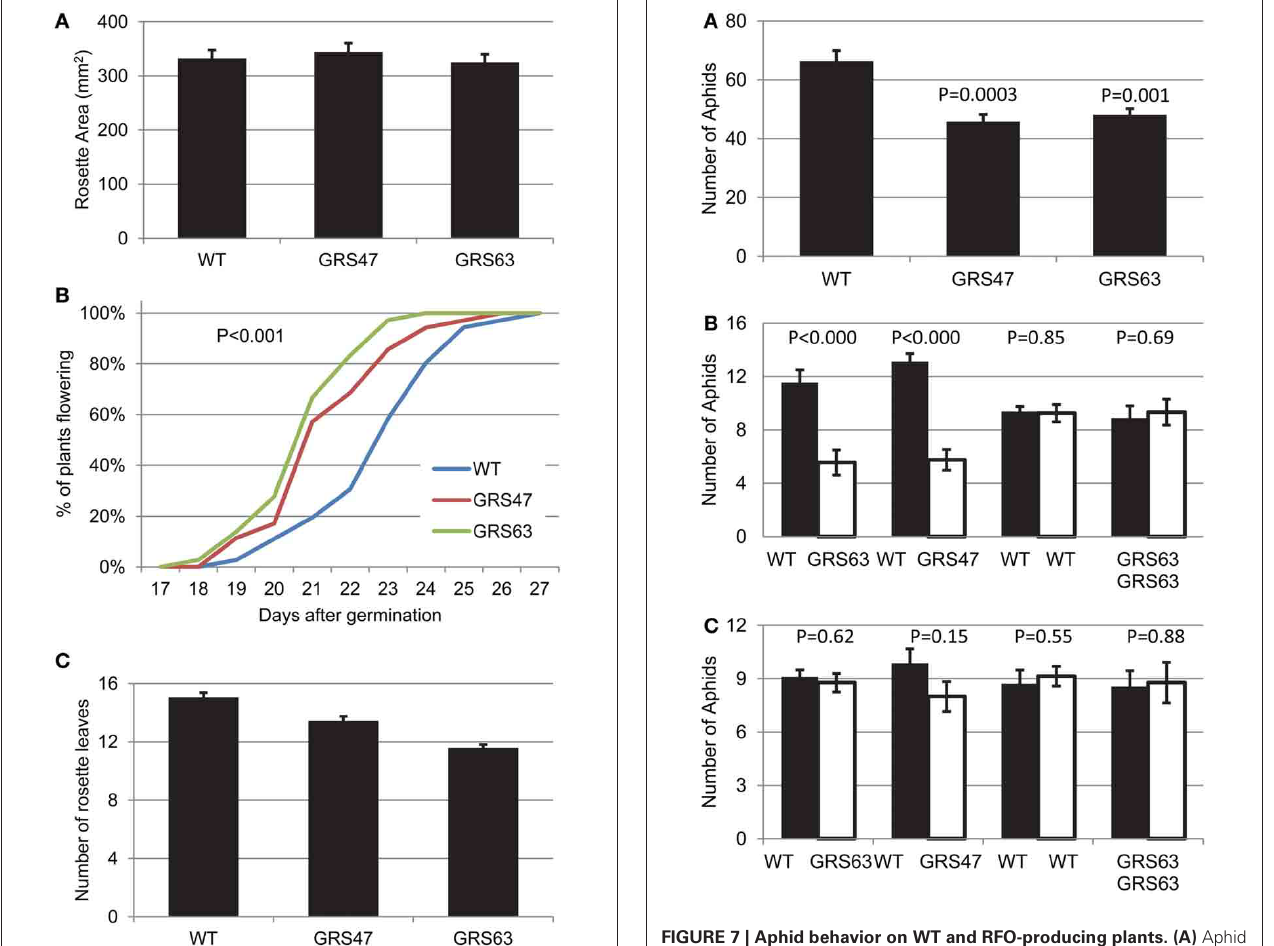
FIGURE 7 | Aphid behavior on WT and RFO-producing plants. (A) Aphid populations on each plant after 48h in a “no-choice” experiment (starting population = 20 adults). Average and SE, n = 12. (B) Adult aphids settled on each plant after 24h in a “choice” experiment (starting population = 20 adults, released equidistant between the indicated plants). (C) As in (B) , but 8h after aphid release. (B,C) , average and SE, n = 9. t -test p -values are indicated on each